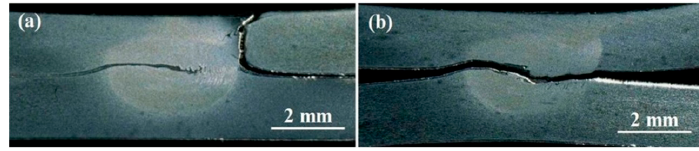
Figure 7. Enlarged views of the failed joint (100 mm/min): ( a ) AS loading; ( b ) RS loading [9].